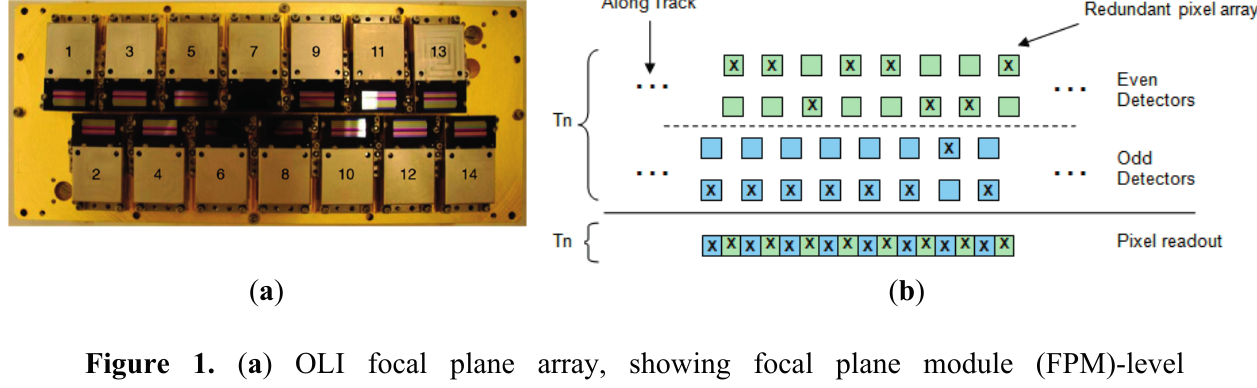
Figure 1. ( a ) OLI focal plane array, showing focal plane module (FPM)-level staggering [5]; ( b ) example of even-odd detector staggering within a VNIR band